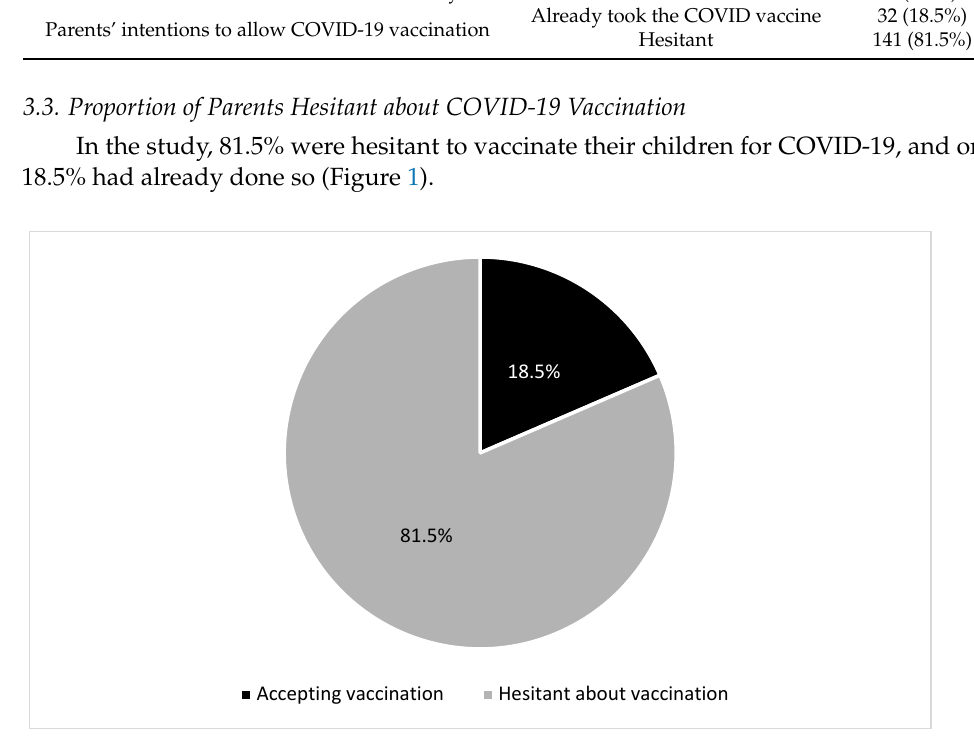
Figure 1. Attitudes of parents of patients with chronic liver disease toward the COVID-19